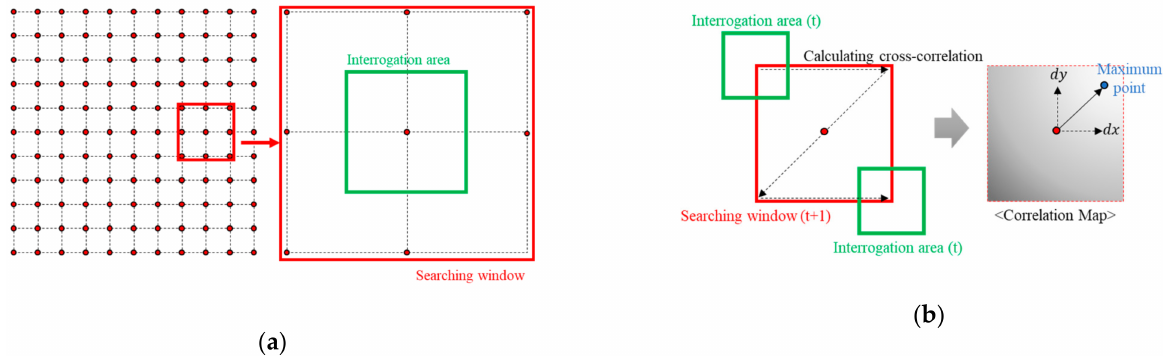
Figure 1. Conventional template matching technique: ( a ) configuration of the searching window and interrogation area, which are parameters of this technique; ( b ) calculation process of the correlation coefficient map using these parameters to find the displacement of the grid point in two